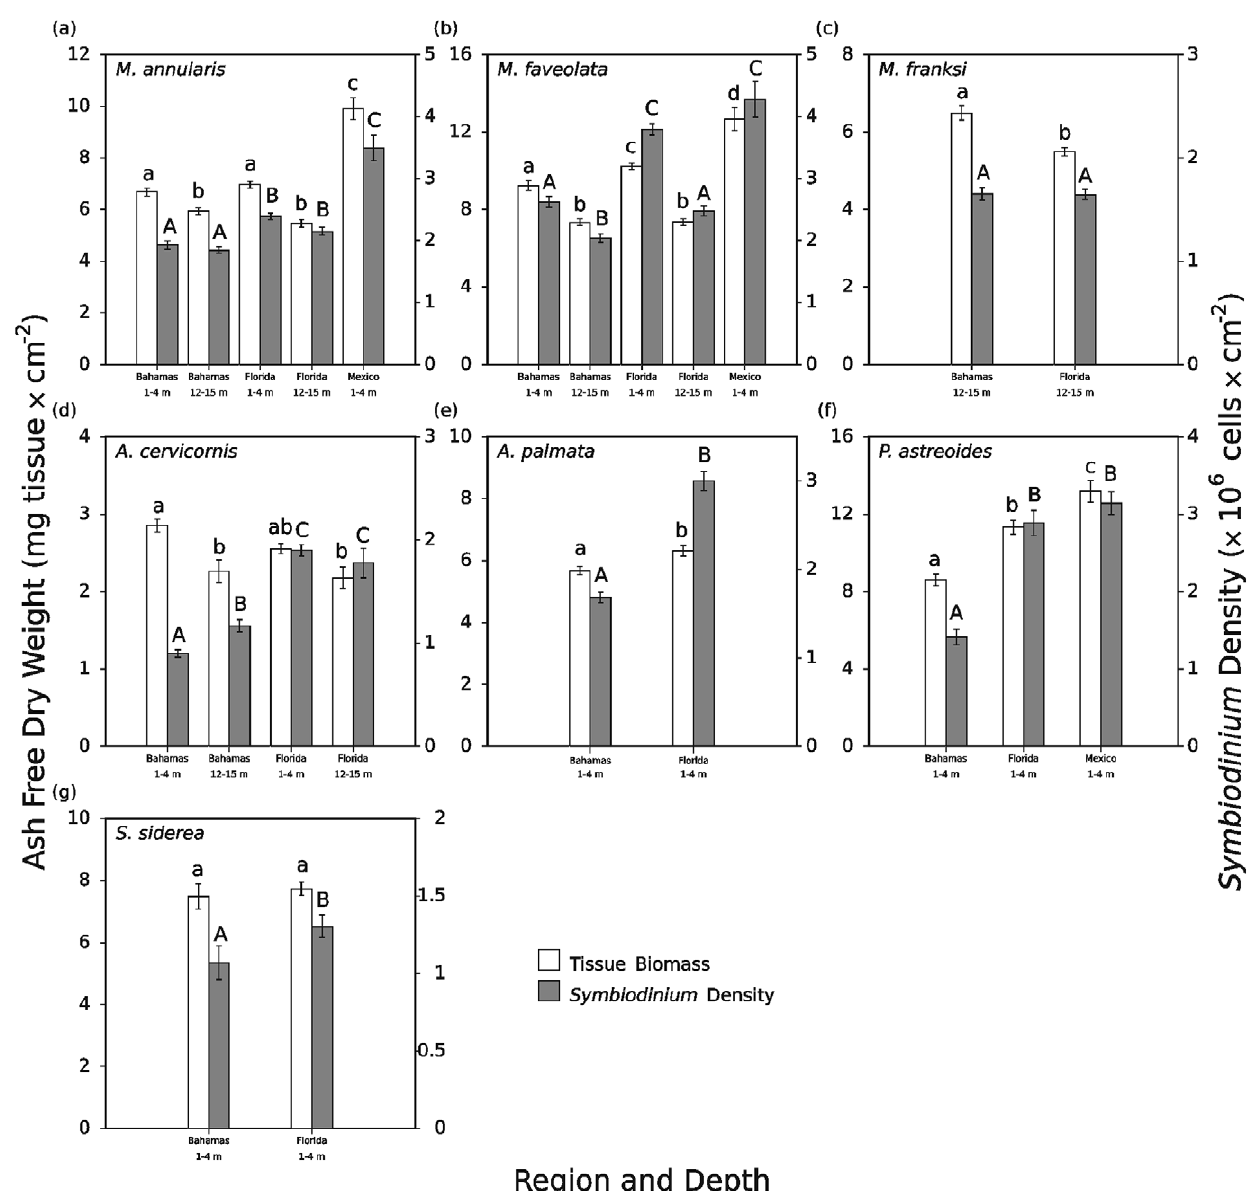
Figure 4. Coral tissue biomass and Symbiodinium density by region and depth within regions. Coral tissue biomass (left axis and white bars) and Symbiodinium density (right axis and shaded bars) data presented as mean values 6 standard error. Statistically distinguishable versus indistinguishable patterns (at a =0.05) are indicated letters above the histograms for each species (using lower case letters for tissue biomass and upper case letters for Symbiodinium densities). Statistical analyses conducted by either two-factor ANOVAs (for M. annularis , M. faveolata , A. cervicornis , and P. astreoides ) or T-tests (for M. franksi, A. palmata, and S. siderea ). Coral species identity is indicated (upper left) for each sub-panel.